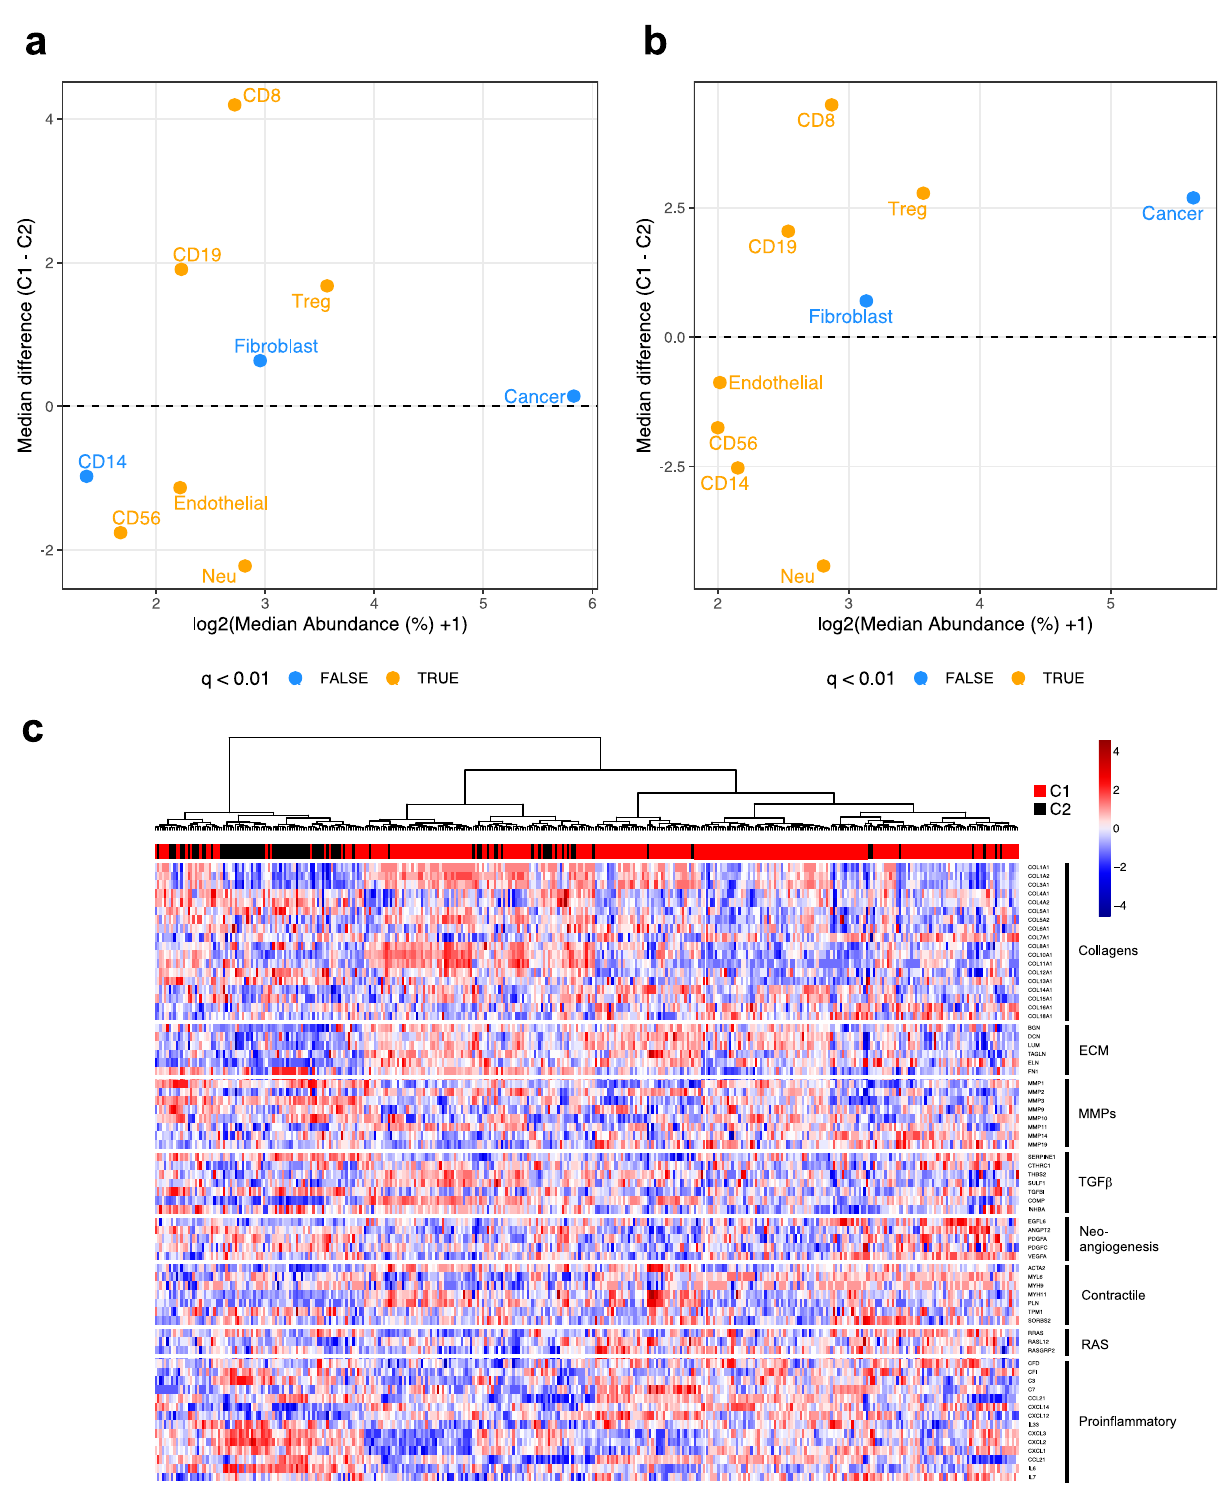
Fig. 6 | Differences in the tumour microenvironment between cervical cancer subgroups. Plotshowingmedianabundances(x-axis)andmediandifferences(%,y- axis) for different cell types estimated using MethylCIBERSORT, with signi fi cant differences(FDR<0.01,WilcoxonRankSumTest)inorange,for a TCGAcohortand b combined validation cohorts. c 68 genes in genesets associated with different